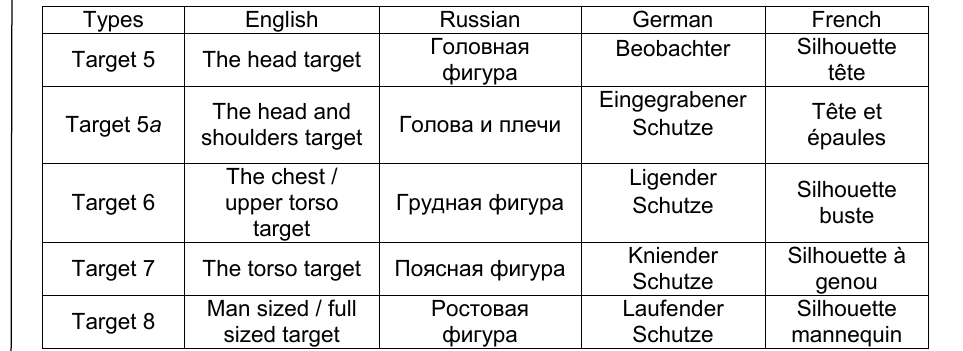
Table 1 – Four language -interpretations of the PSTs